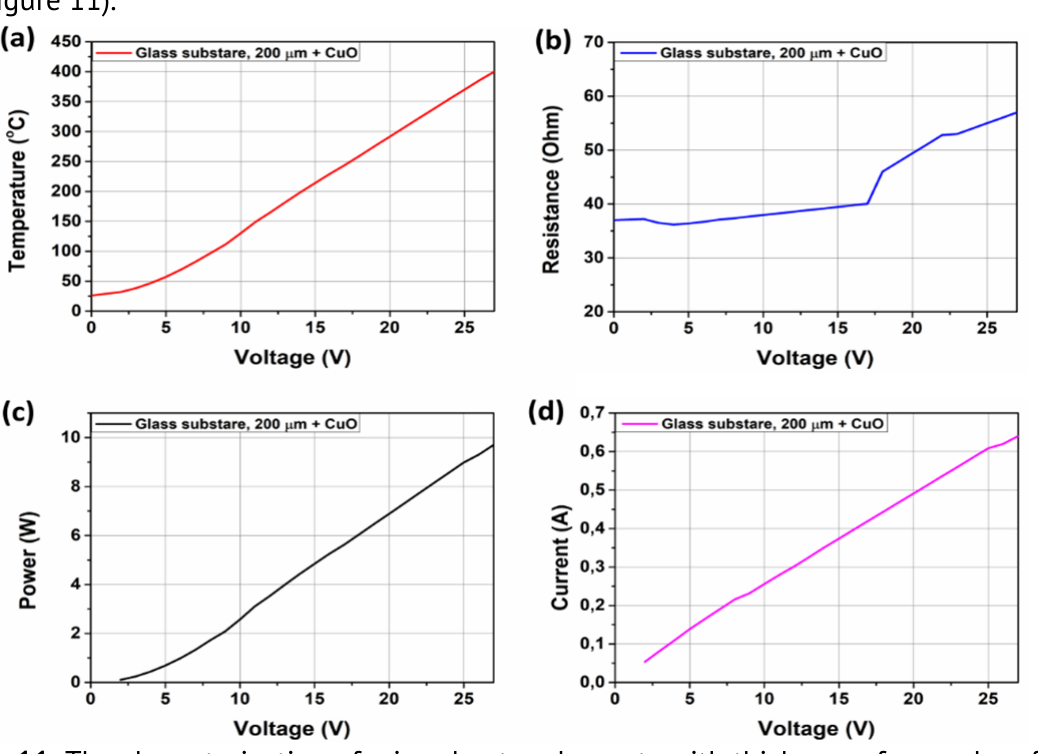
Figure 11. The characterization of micro-heater elements with thickness of meander of 200 μ m deposited on glass substrate and with deposition of CuO nanostructured film: (a) Temperature dependence of voltage front; (b) Resistance dependence of voltage front; (c) Power dependence of voltage ramp; and (d) Current dependence of voltage front to sample deposited on glass with nickel contacts and the CuO nanostructures deposited film and afterwards it was heat treated at 425 o C.